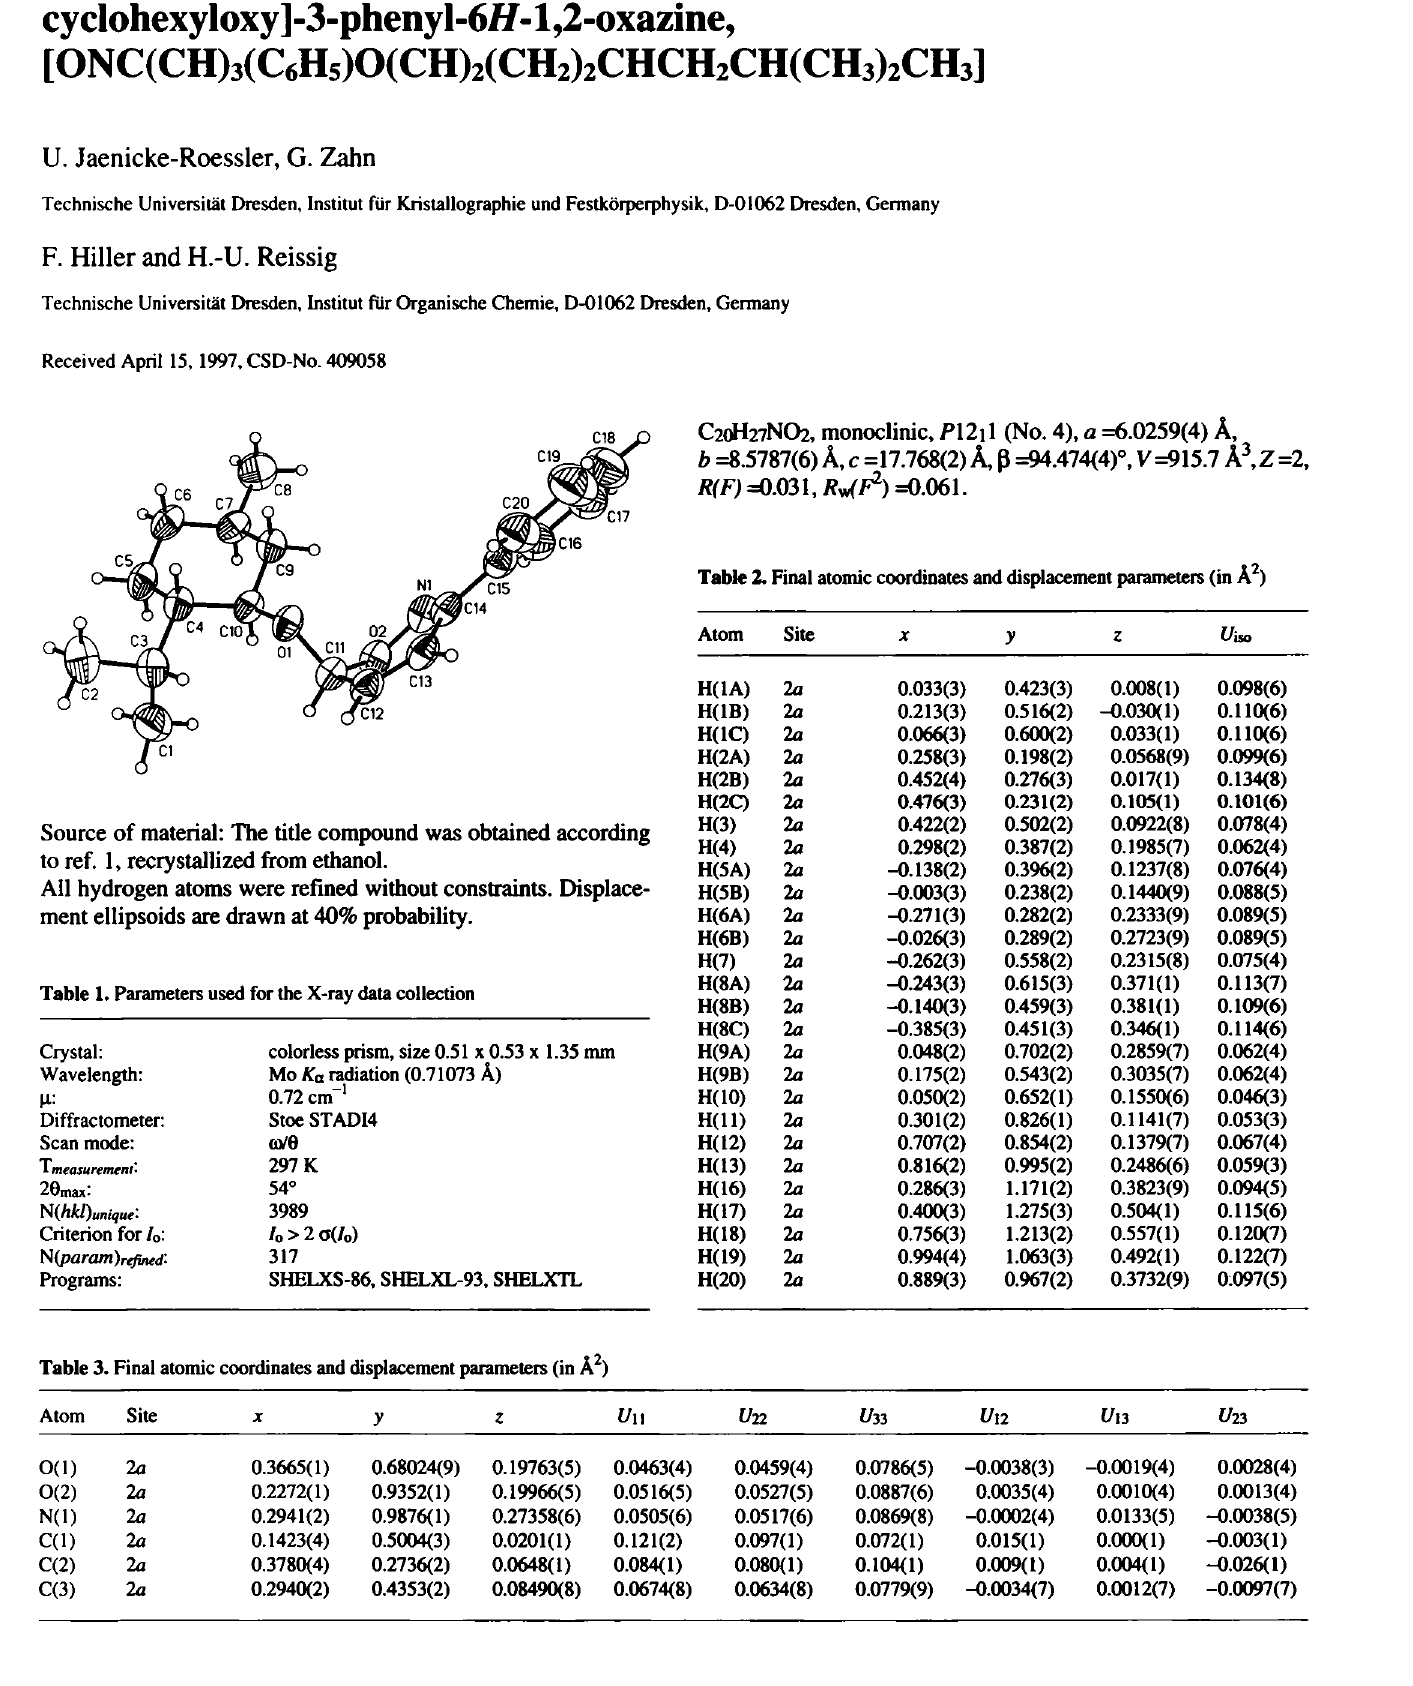
Table 2. Final atomic coordinates and displacement parameters (in Â^)